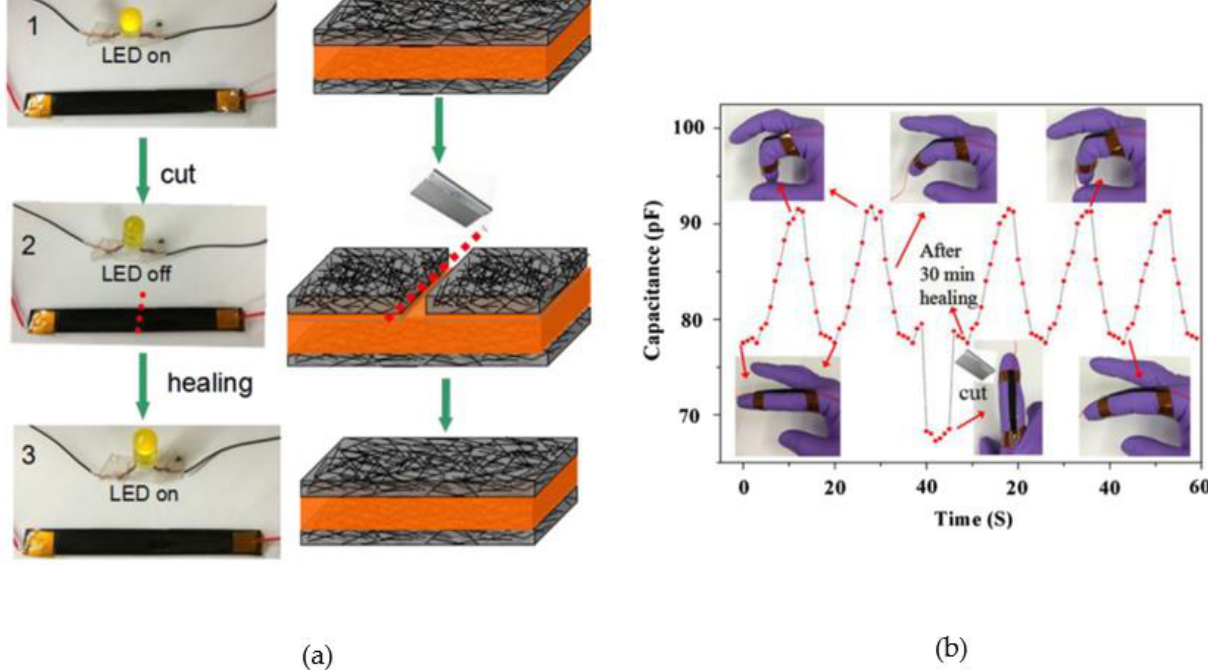
Figure 8. ( a ) The self-healing process of an electrode based on SWCNT’s spread on a flexible, self-healing substrate. Most-top image shows the functional circuit before cutting (LED-ON), middle images show the circuit with the electrode cut (LED-OFF) and the bottom image shows the restored circuit after self-healing process (LED-ON). ( b ) Self-healing finger sensor that can detect various figure motions based on variations in capacitance, reprinted with permission from [95].